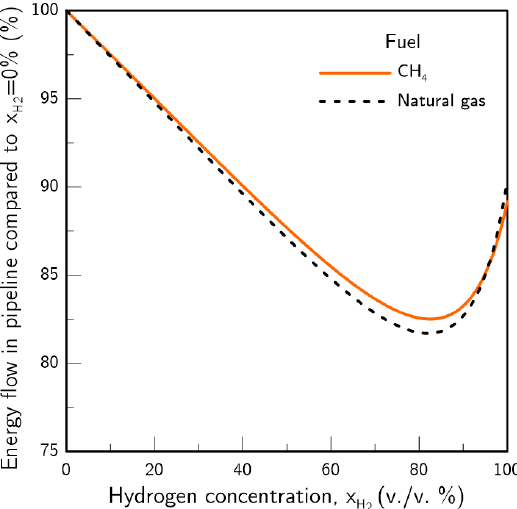
Figure 2. Energy content of gas blends in pipeline flow relative to the energy content of pure CH and NG assuming an unchanged pressure drop and same pipeline